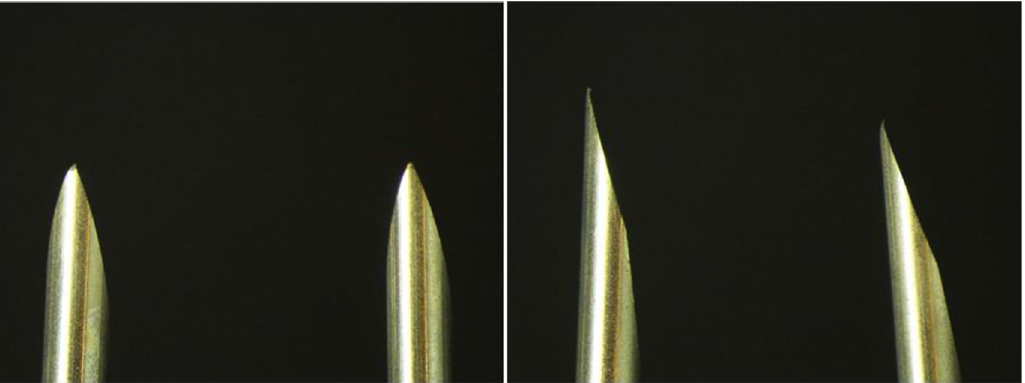
Figure 4: Examination of blunt and bent 20G needle tips after insertion into stopper (images viewed under 10 × eyepiece lens, 1 × objective lens, and zoomed 8 × for a total magni fi cation of 80 ×